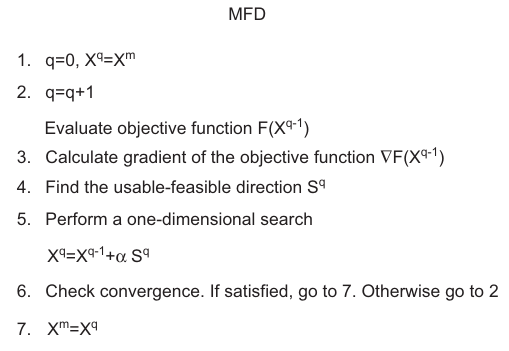
Figure 2 Flow chart of the MFD